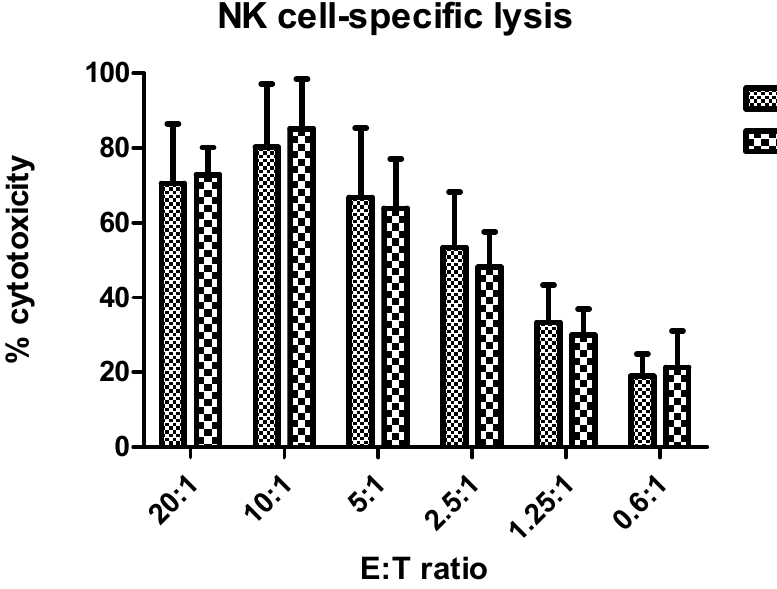
Figure 7. Survivin treatment had no effect on NK cell cytotoxicity. To determine cell-specific killing capacity of NK cells, the release of cytoplasmic lactate dehydrogenase (LDH) from lysed target K562 (erythroleukemia) cells (5 × 10 5 /well) was measured using the CytoTox 96 non-radioactive cytotoxicity assay. Serial dilutions of the effector to target (E:T) ratio from 20:1 to 0.625:1. NK effector cells were activated overnight with IL-2 (100 U/mL) and treated with 10 µ g/mL survivin for 24 h before being co-incubated with K562 cells for 4 h. Upon conclusion of the incubation at 37 ◦ C, the LDH-containing media was transferred to a separate plate and absorbance read at 490 nm with a Bio-Tek µQuant microplate reader. The percentage of specific lysis was calculated according to a standard equation, specific lysis (%) = (experimental release − effector spontaneous release − target spontaneous release)/(target maximum release − target spontaneous release) × 100.